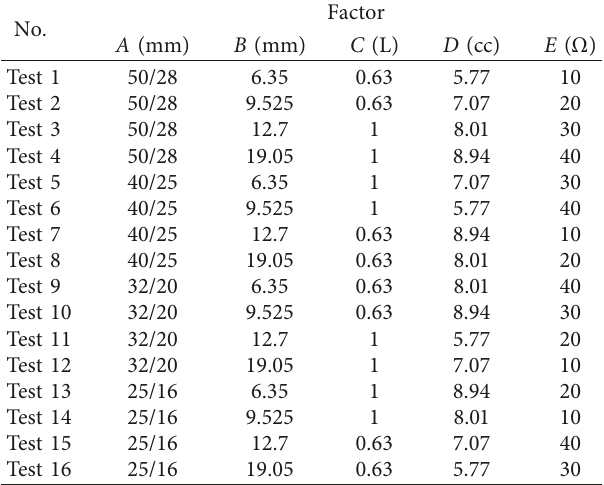
Table 8: Orthogonal simulation test design list L